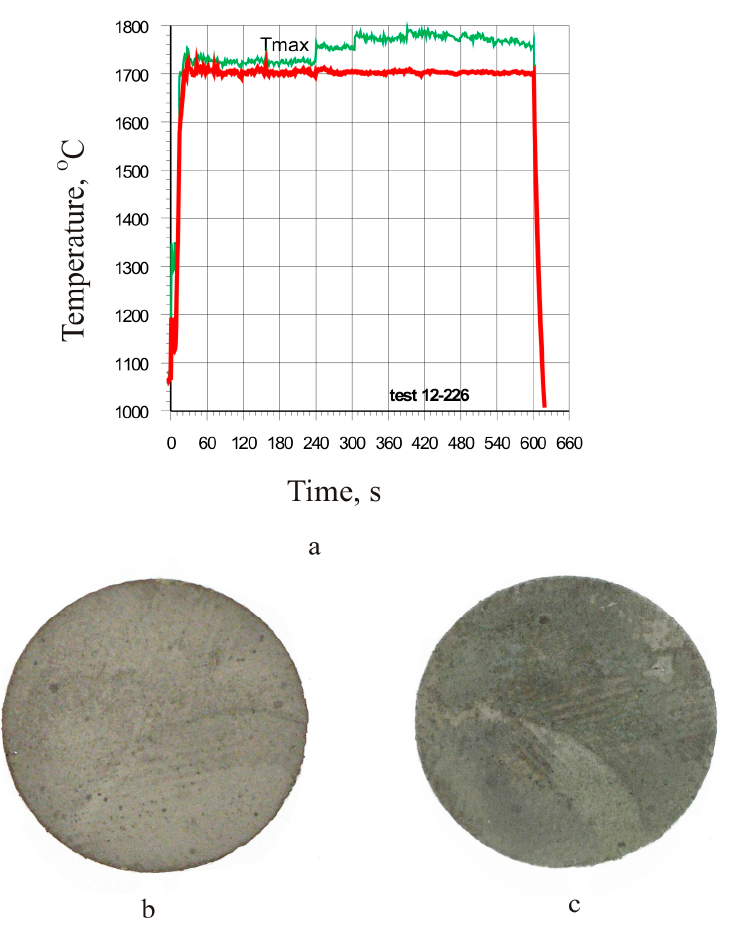
Figure 5. Test thermograms for a CCCM sample 50 mm in diameter with a protective SiC coating ( a ) and its appearance before ( b ) and after ( c ) testing.